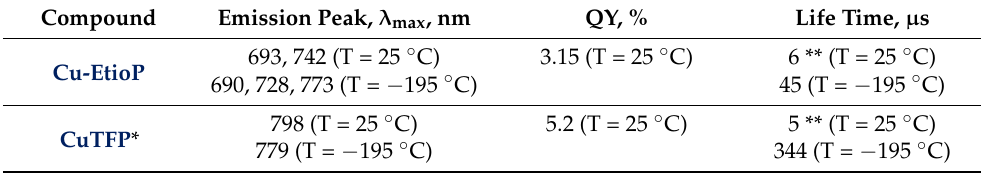
Table 1. Photophysical data for copper(II) porphyrinates measured in polystyrene film.